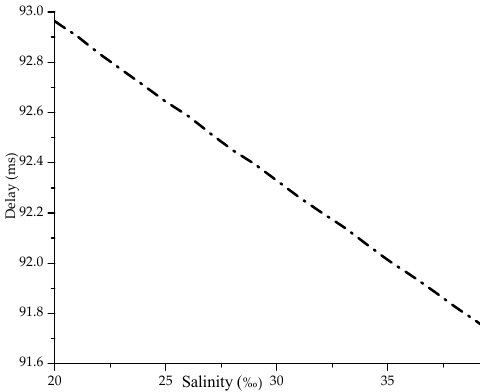
Figure 5. Total delay for di ff erent values of salinity.